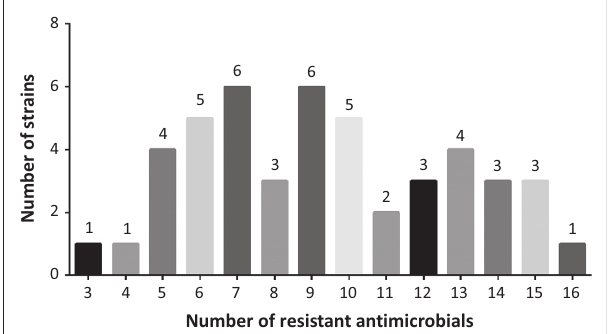
FIGURE 1: Distribution of Escherichia coil strains resistant to antimicrobials.